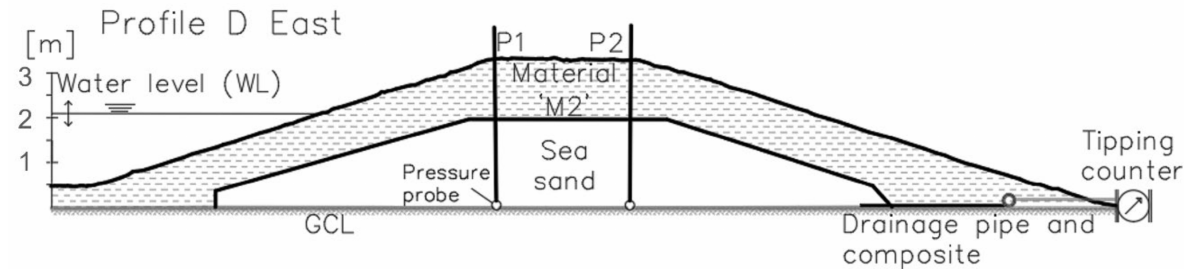
Figure 1. Cross-section D (east) of Rostock research